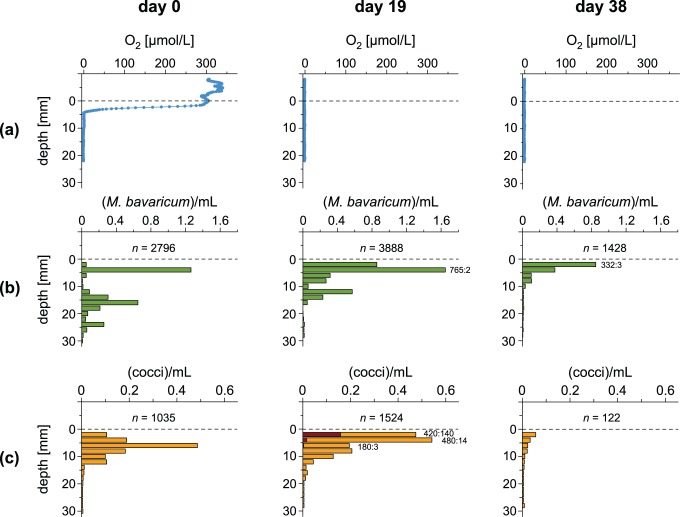
Evolution of oxygen concentration and cell counts in a microcosm under anoxic atmos­phere.(A) Oxygen profiles in water and sediment (0 = sediment/water interface), measured 0, 19, and 38 days after exposure to an oxygen-free atmosphere. (B–C) MBV and MCC cell concentrations as a function of sediment depth. Total MTB populations n (in 106 cells/m2) and NS:SS proportions are given in each plot. Significant concentrations of SS cocci at day 19 are plotted as red bars.